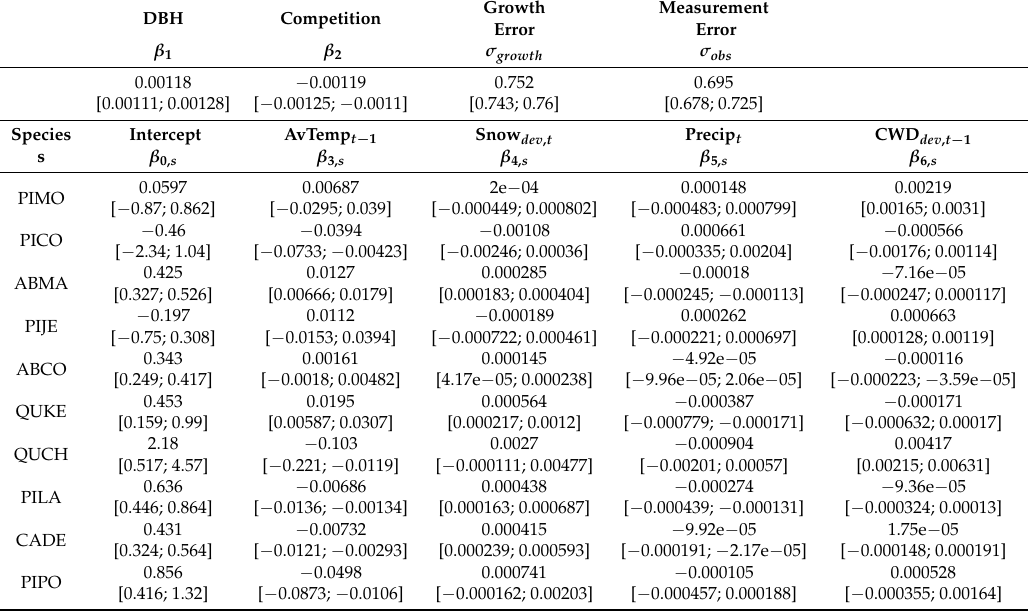
Table A5. Parameter estimates for the final model including AvTemp of previous year, snow